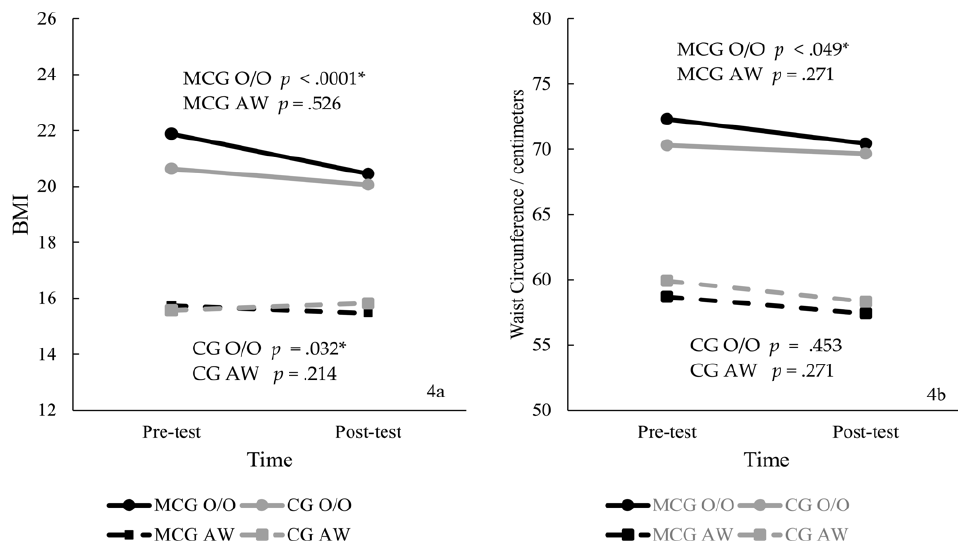
Figure 4. BMI ( 4a ) and waist circumference ( 4b ) by group (* significant